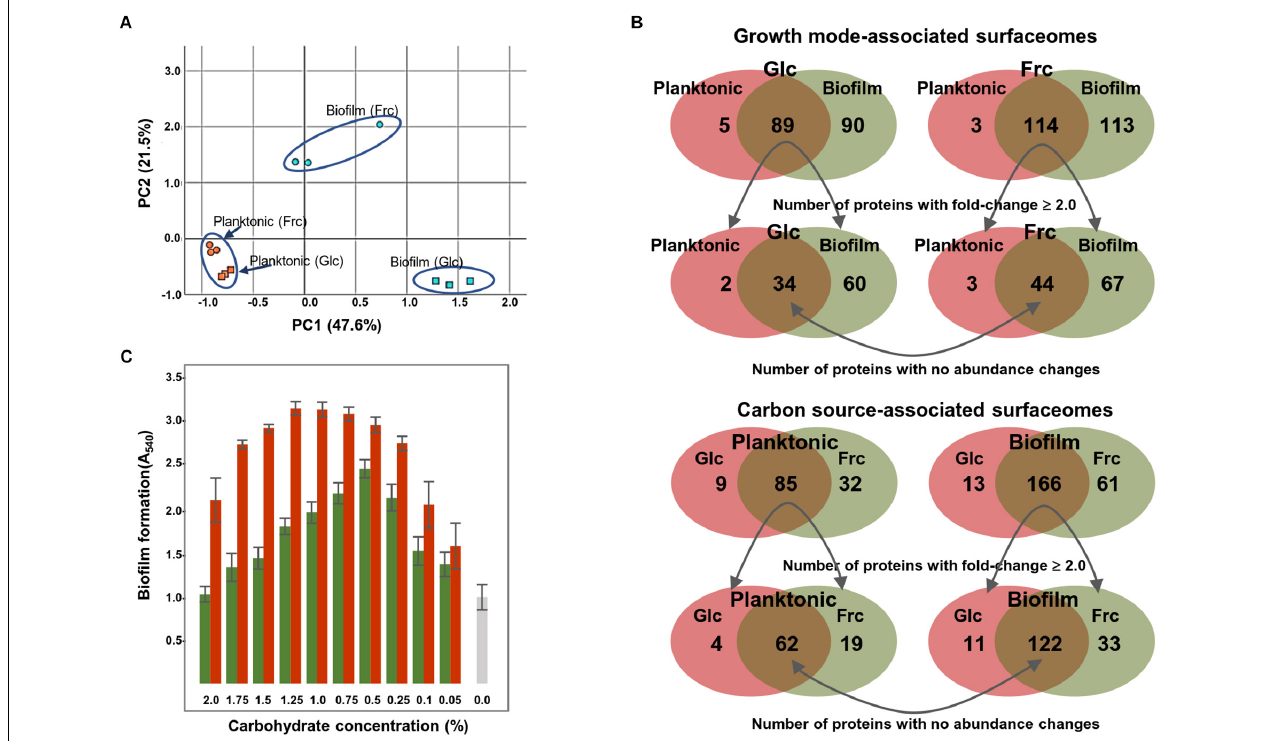
FIGURE 2 | (A) Surfaceome variability among GG cells cultured under four different conditions (two carbon sources and two growth modes) assessed by PCA. PC1 (growth mode) accounts for 47.6% and PC2 (carbon source) accounts for 21.5% of the variation. (B) Venn diagrams indicate the number of commonly and specifically identified surfaceome proteins. (C) Biofilm formation of GG in varying concentrations of fructose (red bars) and glucose (green bars) and with no carbohydrate (gray bar). The biofilm formation efficiency was monitored after 48 h of incubation at 37 ◦ C in the presence of 5% CO 2